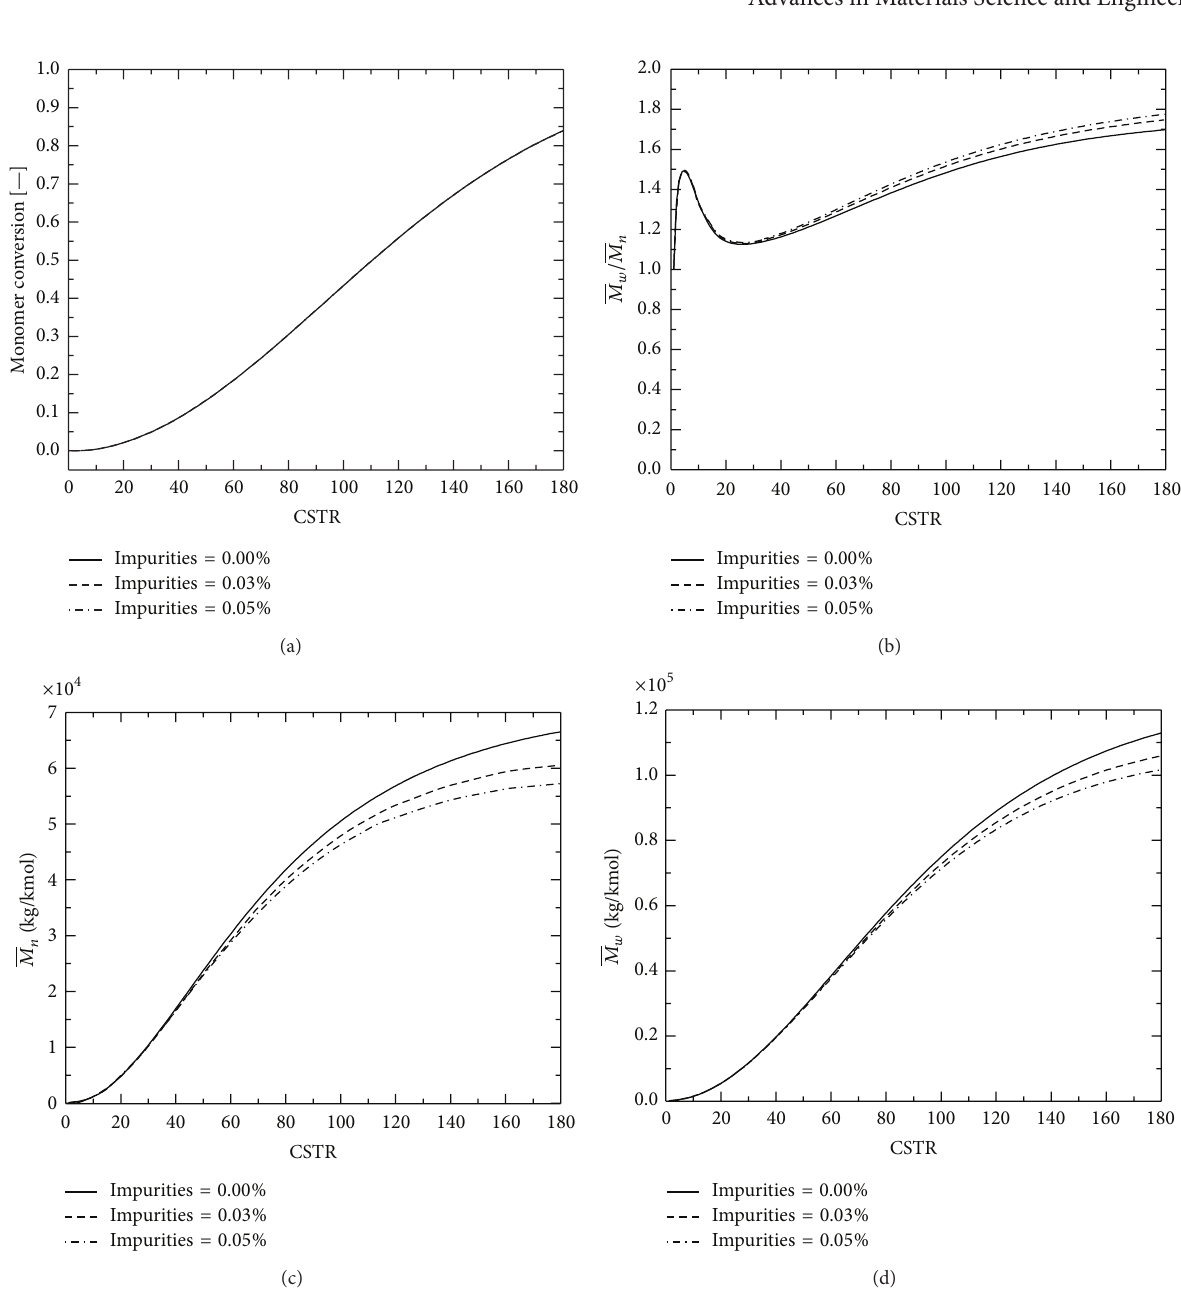
Figure 5: Effect of the impurities concentration on (a) the monomer conversion, (b) polydispersity index, (c) the weight average molecular number 𝑀 𝑛 , and (d) the weight average molecular weight 𝑀 𝑤 , at 𝑇 = 190 ∘ C, 𝑀 0 /𝐼 0 = 2250 , and rpm =